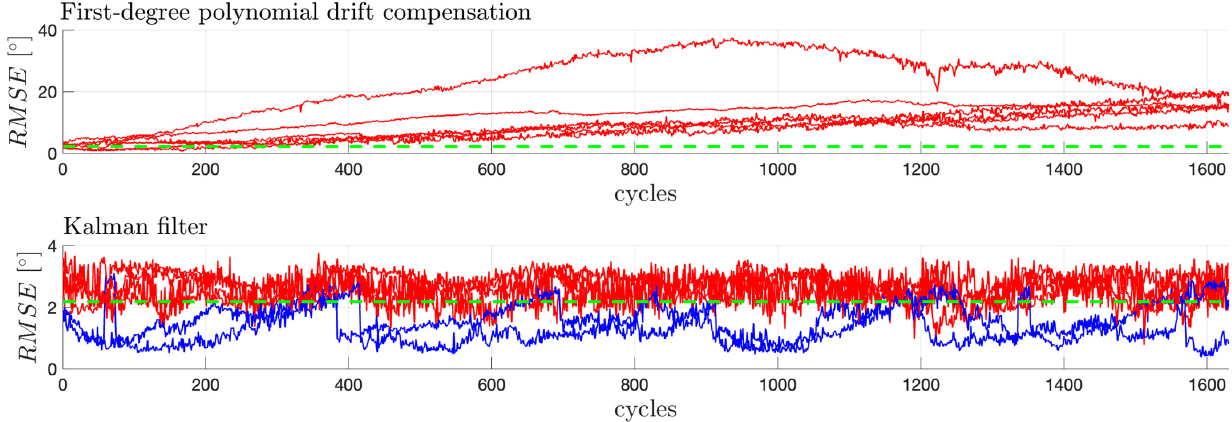
Figure 7. Knee joint angle root mean square error ( RMSE ) by crank cycle for all conducted 20 min measurements. The green dashed line represents the average entire trial RMSE of the Kalman filter calculated across all cycles and all subjects. The red lines represent measurements for which the average RMSE per cycle exceeds the average RMSE of the Kalman filter.